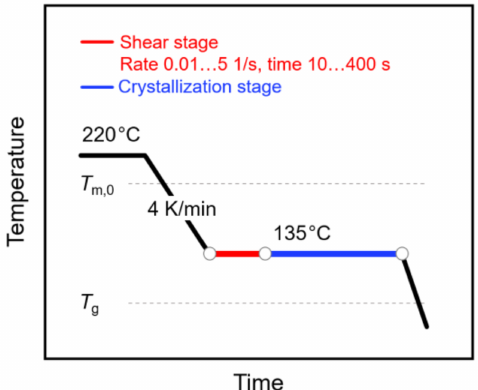
Figure 1. Temperature–time profile for analysis of shear-induced crystallization of poly ( L -lactic acid) (PLLA). The relative positions of the equilibrium melting temperature ( T m ,0 ) and of the glass transition temperature ( T g ) are indicated with the gray dash lines.